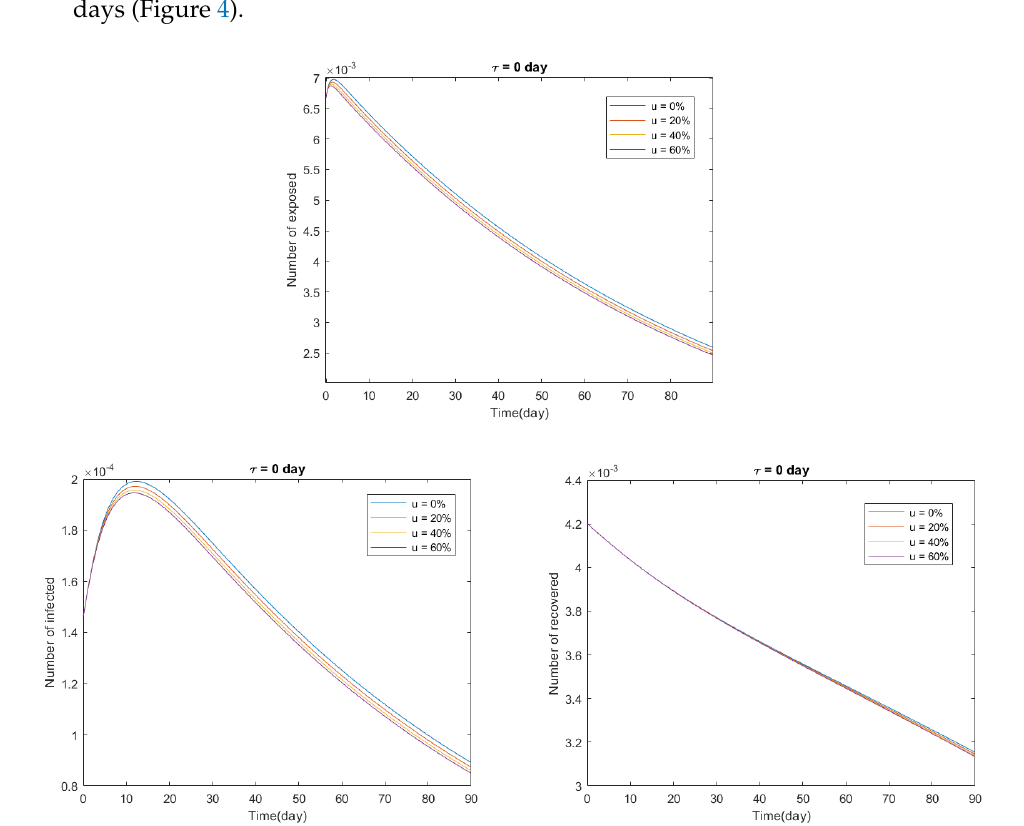
Figure 3. Predictions for Italy from the delayed model (24) with τ = 0 and u ∈ { 0%,20%,40%,60% } , between 18 October 2020, and 19 January